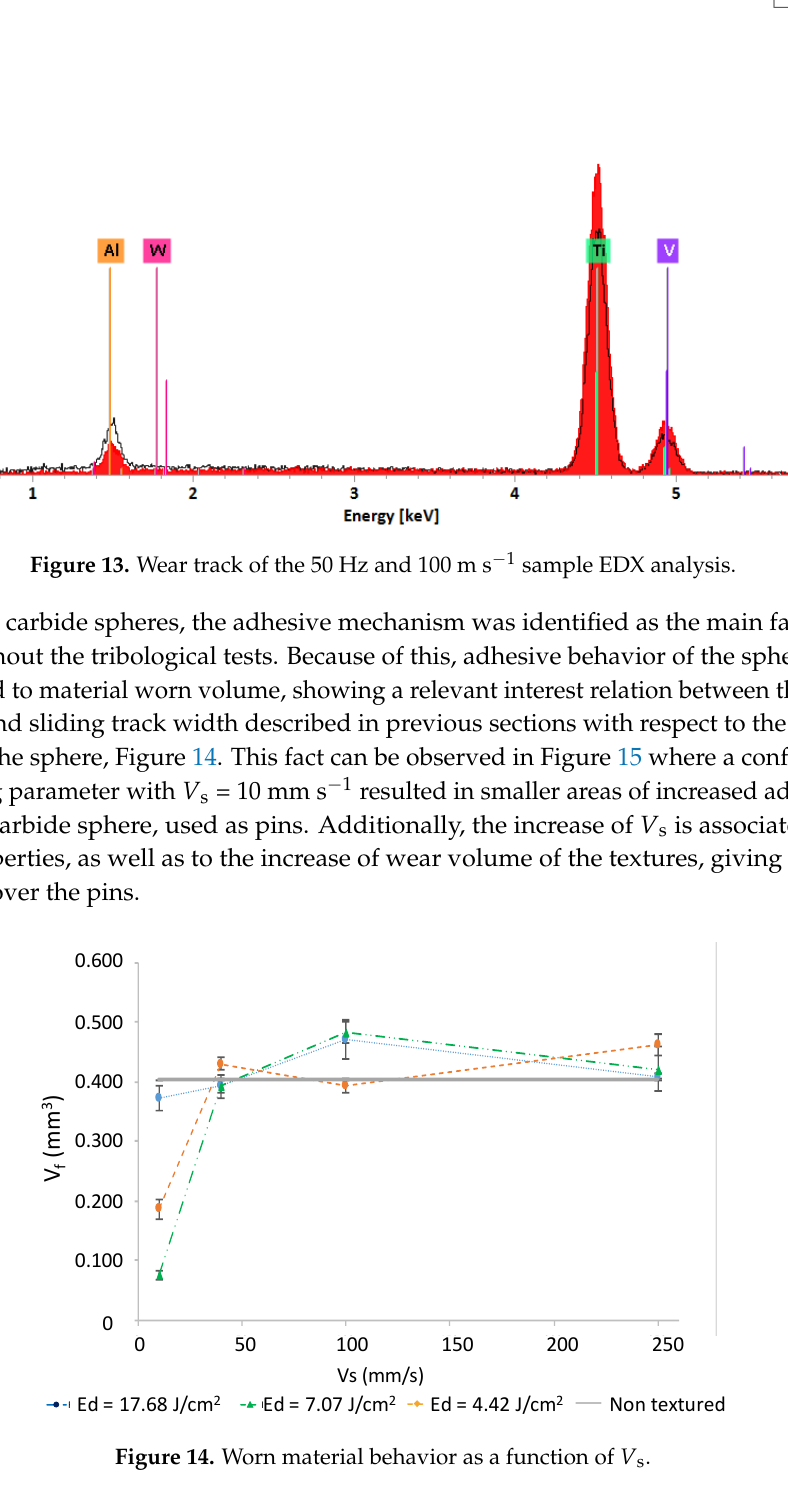
Figure 12. SEM of the wear track of the 50 Hz and 100 mm s −1 treated sample; ( a )200×, ( b )750×.